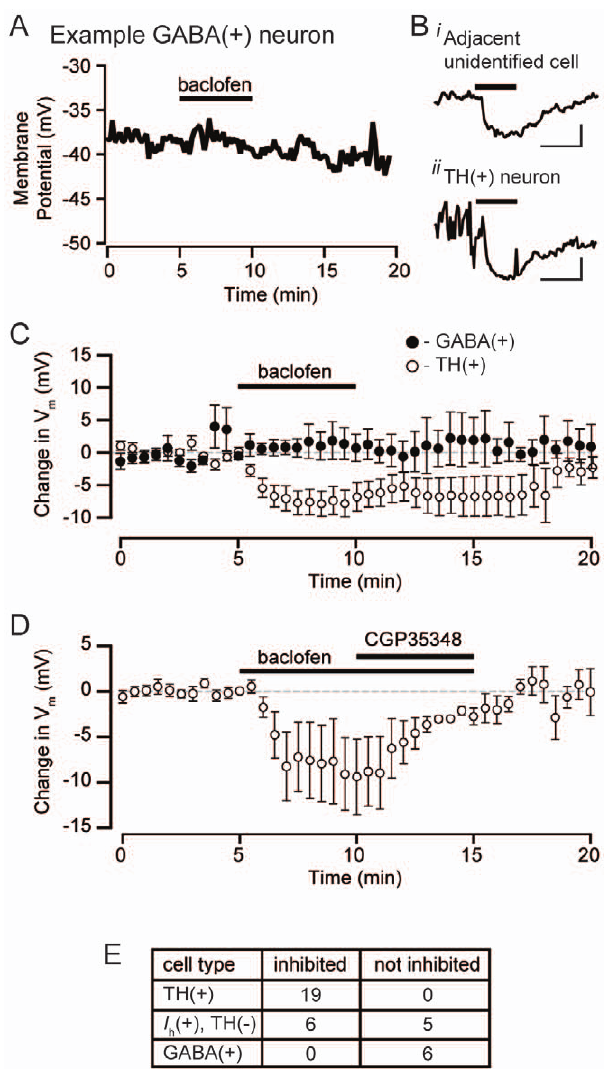
Figure 10. GABA B receptor activation inhibits VTA dopamine neurons, but not VTA GABA neurons. (A) Example current clamp traces from cytochemically identified GABA neuron lacking a response to the GABA B receptor agonist baclofen (1 m M). (B i ) An unidentified neuron recorded on the same day as GABA( + ) neurons that were insensitive to baclofen shows a significant hyperpolarization in response to baclofen (1 m M; bar). (B ii ) Example of a cytochemically identified dopamine neuron hyperpolarized by baclofen (1 m M; bar). Scale bars: 5 mV and 5 min. (C) Average trace of identified GABA neurons (n=6) tested with bath application of baclofen (1 m M) compared to the averages of all quiescent confirmed dopamine neurons (n=8). (D) Average trace of 4 neurons significantly inhibited by baclofen (1 m M); the inhibition was reversed by the GABA B receptor antagonist CGP35348 (10 m M). (E) Table of all observed baclofen responses across confirmed GABA, dopamine, and I h ( + ), TH( 2 ) neurons. TH-identified neurons include spontaneously firing, quiescent (from panel C), and voltage-clamp experiments.